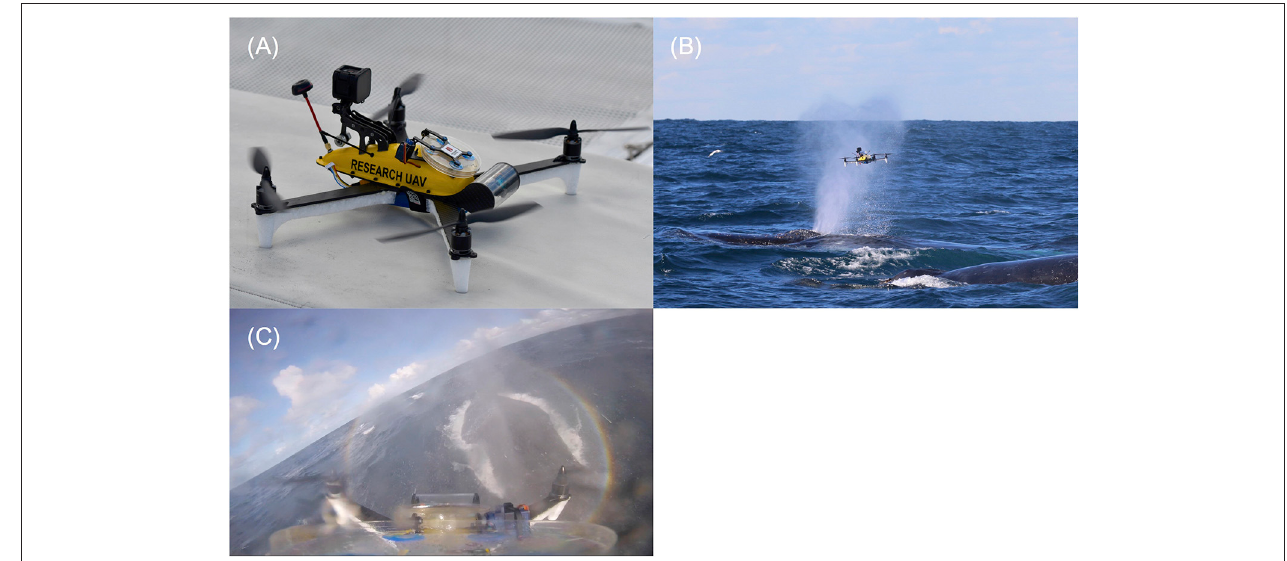
FIGURE 2 | (A) Purpose-built UAV designed to sample whale blow. The UAV consists of a sandwich style carbon fiber body. White foam floats support the UAV during take-off and landings and provide floatation in water. The yellow shell houses all electrical equipment. A GoPro ® hero session is mounted at the back of the yellow shell to record flights. A hinge mechanism with disposable petri dish is located in the center of the yellow shell. This can be remotely operated to minimize sample contamination in the field. The clear round tube at the front of the UAV houses the first-person camera to assist with sampling. (B) UAV sampling whale blow. This photo was taken just as the UAV had passed through the visible blow (plume of spray). The petri dish is still in the open position. Sample was collected on both the lid and bottom (nutrient agar filled) side. The petri dish was shut immediately after collection to minimize sample contamination and the drone was flown back to the research vessel > 200 meters away. (C) Screenshot from the UAVs on-board GoPro ® camera mid whale sample collection. This footage shows the petri dish at the bottom of the picture. The whale is located on the right-hand side. The petri dish is completely extended (open) with blow droplets visible on both sides of the dish and GoPro ®